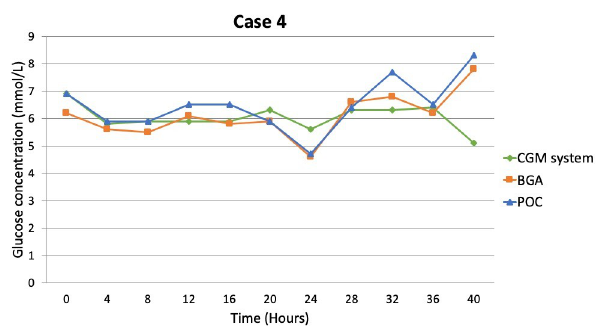
Fig 3. Recorded glucose concentrations in case 4 with continuous glucose monitoring system (CGM system), point of care glucometer (POC) and blood gas analysis (BGA).